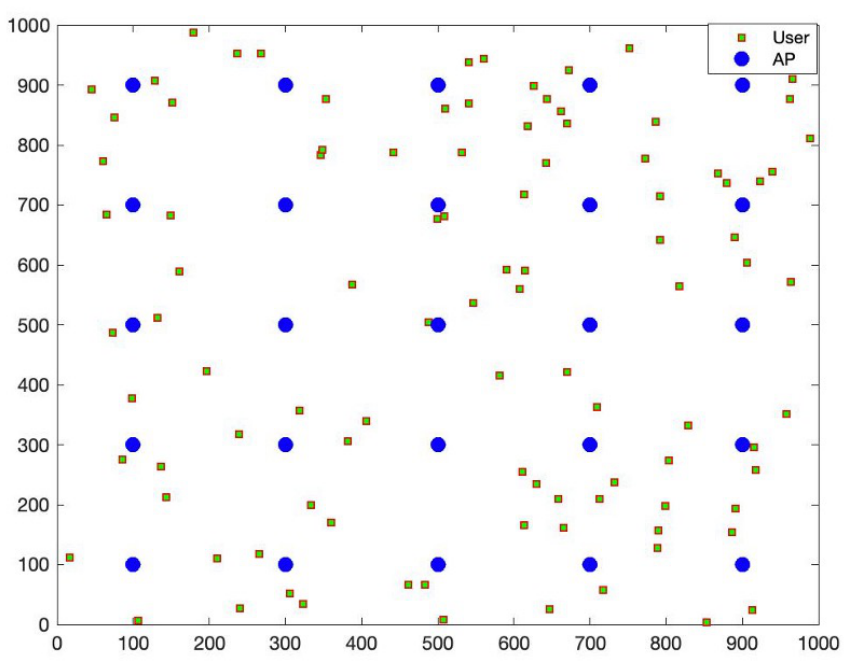
Figure 4. Network topology